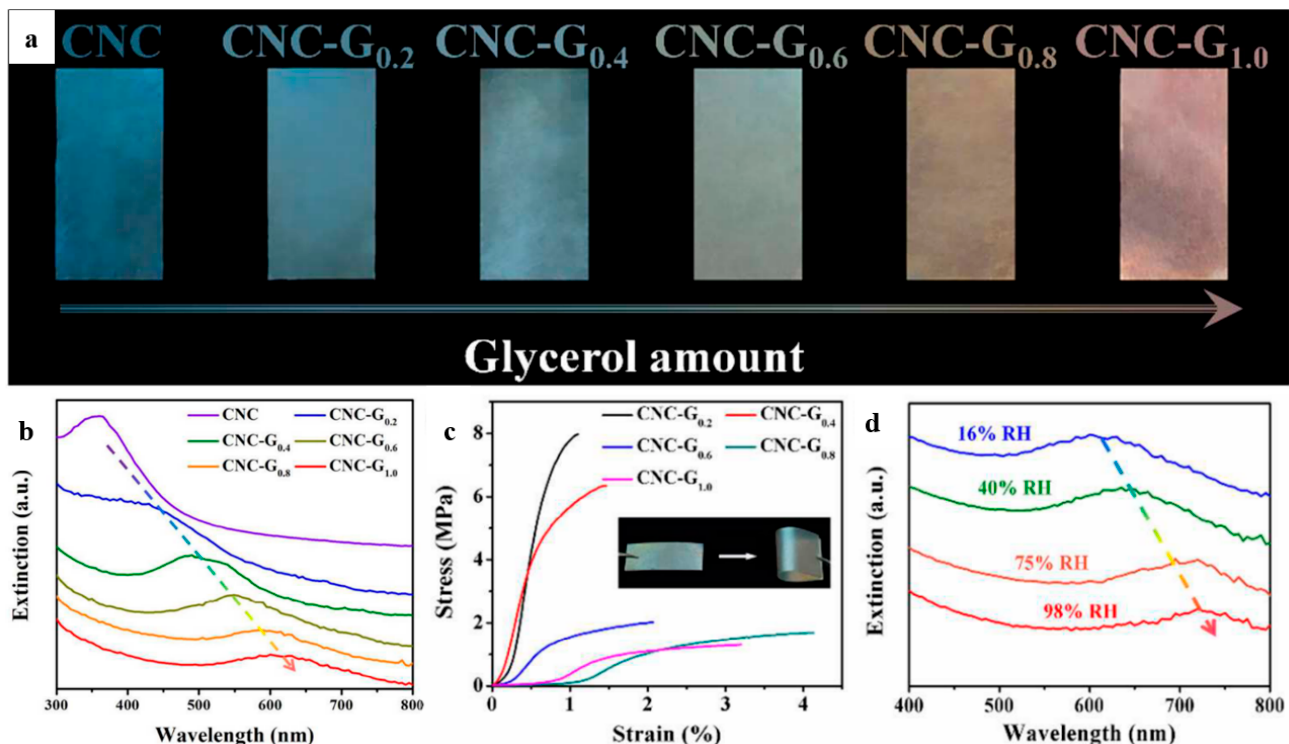
Figure 16. ( a ) Photographs of CNC films prepared with varying glycerol concentration; ( b ) UV-Vis spectra of the resultant CNC/glycerol films; ( c ) tensile property of CNC/glycerol films; and ( d ) effects of humidity-responsive CNC/glycerol films. Reproduced from [106].